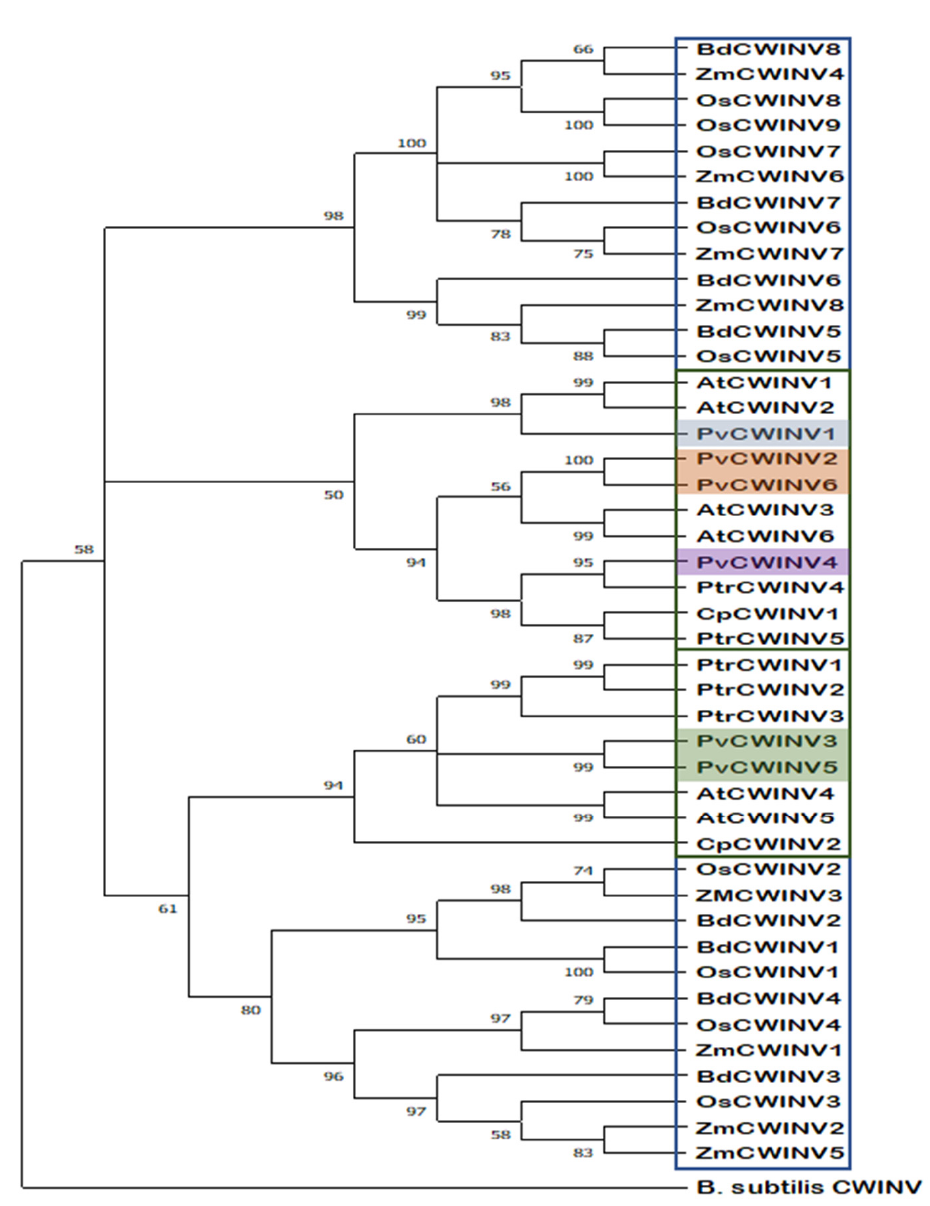
Figure 6. Phylogenetic tree constructed by the NJ method using the MEGA5.2.2 program based on protein sequences of Phaseolus vulgaris and invertases from monocotyledonous (Monocot) and dicotyledonous (Dicot) plants and including cell wall invertases of the bacterium B. subtilis as an out group. Accession numbers are in Table 1 .